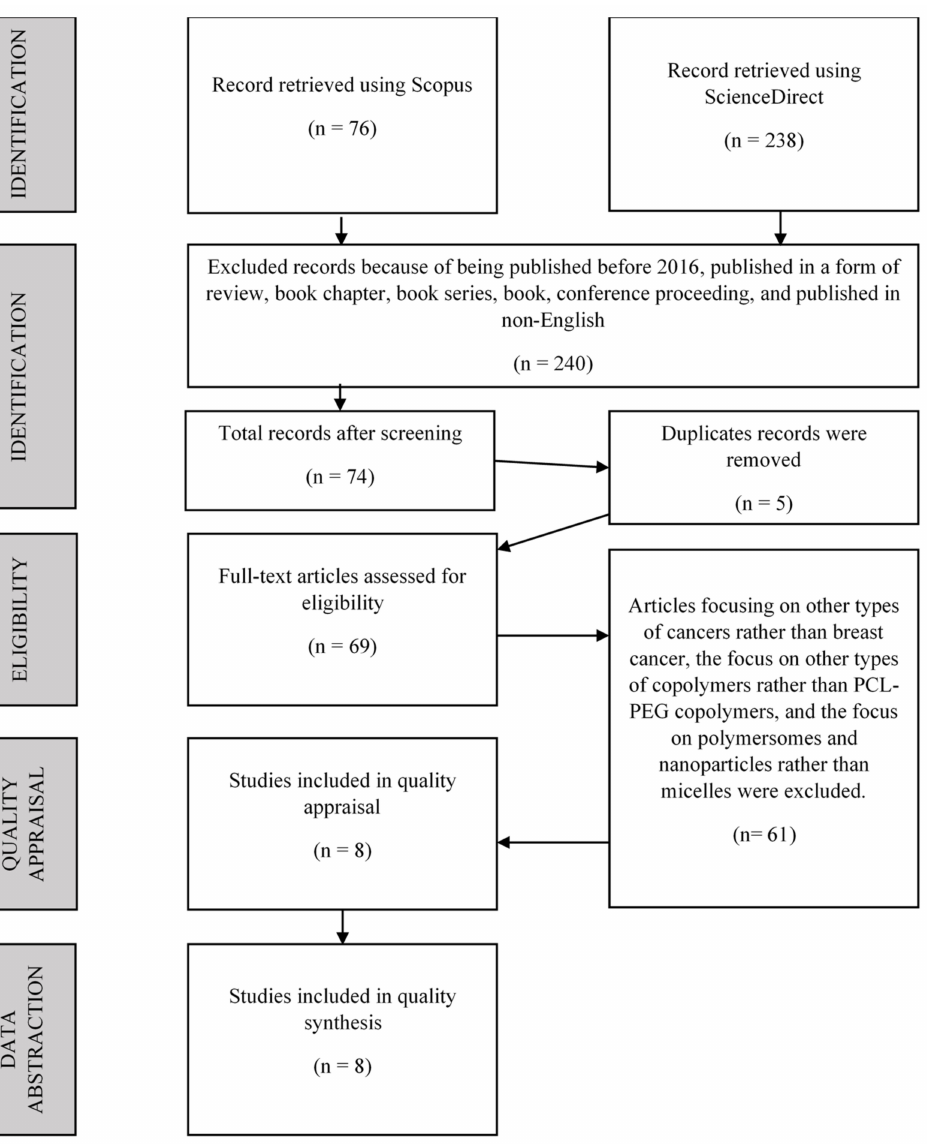
Figure 1. The flow diagram of the systematic literature review (adapted from Mohamed Shaffril et al.